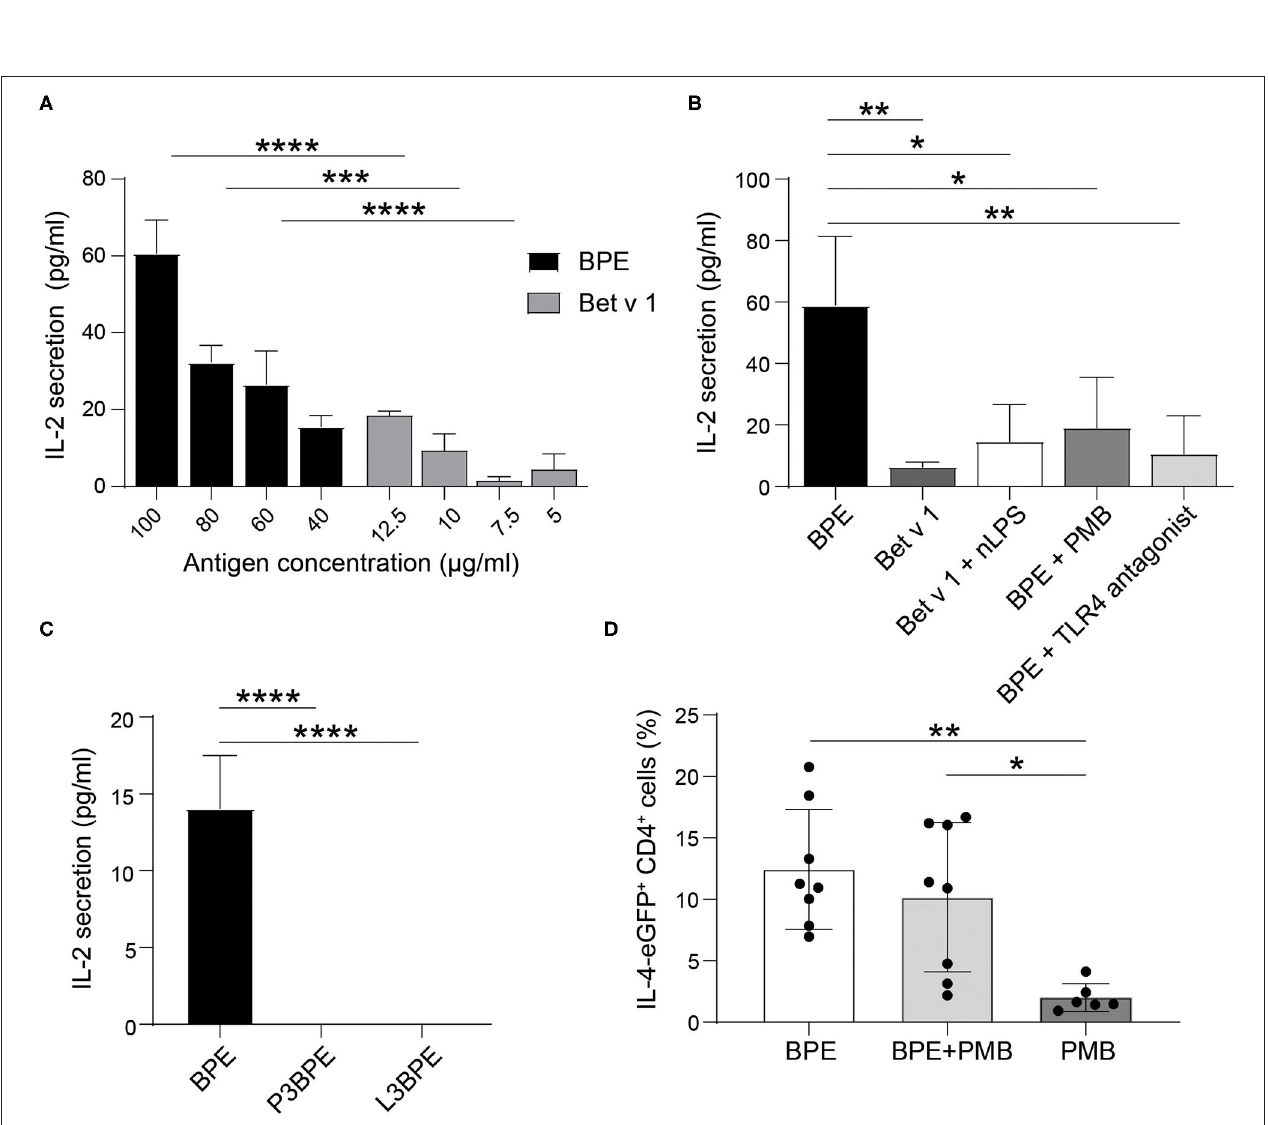
FIGURE 5 | with 2 µ g/ml BPE or 0.26ng/ml nLPS after administration of 260ng/ml TLR4 antagonist (ratio 1:1,000 of nLPS to TLR4 antagonist) was analyzed (B) . Dotted lines represent the average of medium-treated cells. Representative data of two single non-allergic donors are shown in (A,B) . Each assay was repeated with three donors (allergics and non-allergics). Statistics were calculated using a Two-Way ANOVA with a Dunnett’s and Sidak’s multiple comparisons test, respectively. Surface expression of TLR4 after 24h stimulation with different BPE or corresponding nLPS concentrations (C) . Normalized data derived from four independently performed experiments ( n = 4 allergic donors) are shown. The MFI of the data was normalized toward the untreated/medium-treated control (dotted line). For statistics, the untreated reference was compared to treated samples with a mixed-effect analysis with a Dunnett’s multiple comparison test.